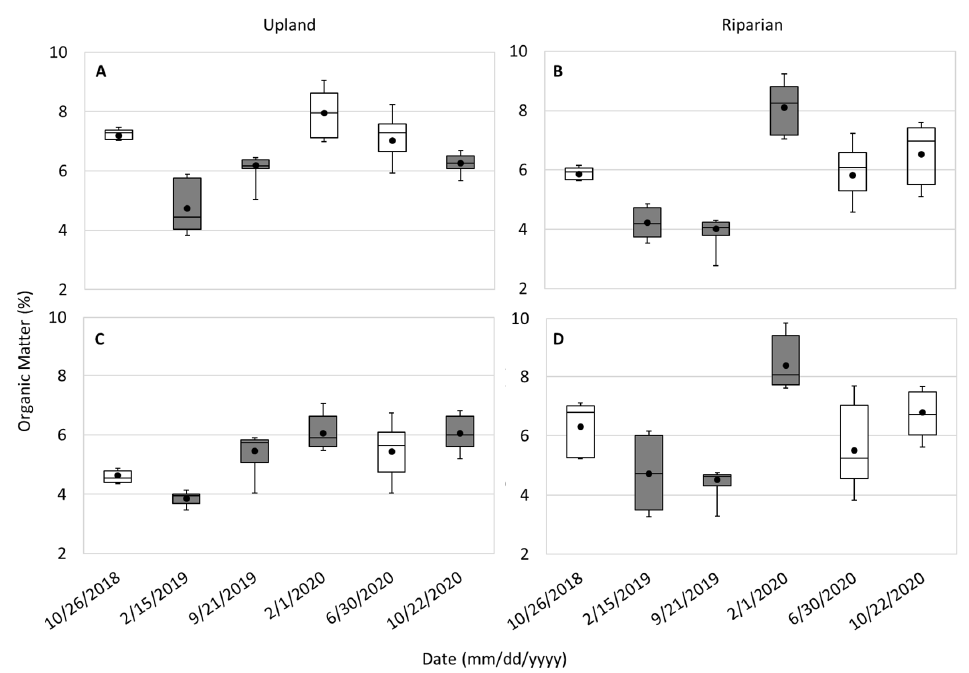
Figure 2. Organic matter box and whisker plots for the upland upper ( A ) and lower ( C ) and riparian upper ( B ) and lower ( D ) soil depths. Dates that are different from 26 October 2018 and statistically significant are shaded.